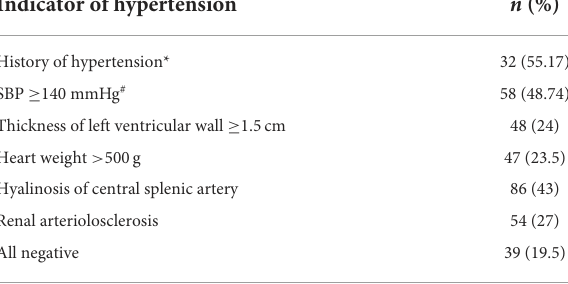
TABLE 6 Hypertensive indicators in TAD